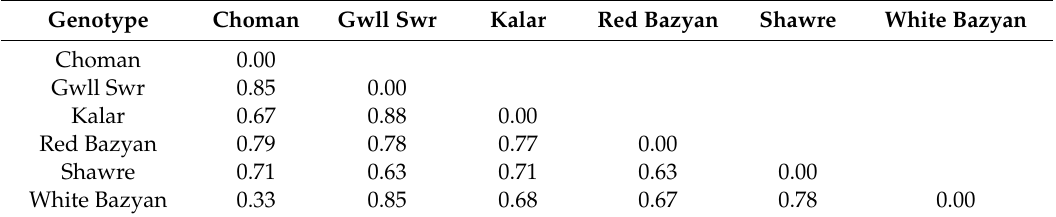
Table 3. Dissimilarity matrix of various rice genotypes using SSR data.